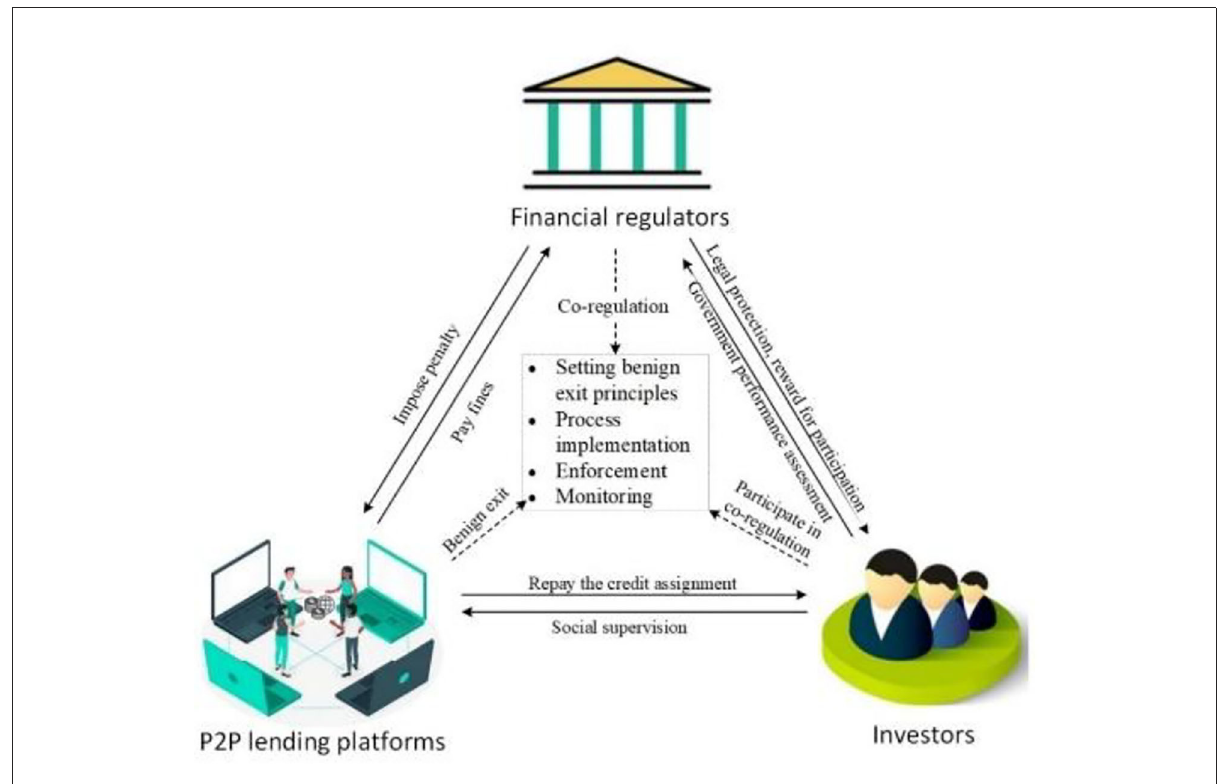
FIGURE2 Co-governance scheme of P2P lending platforms’ benign exit.